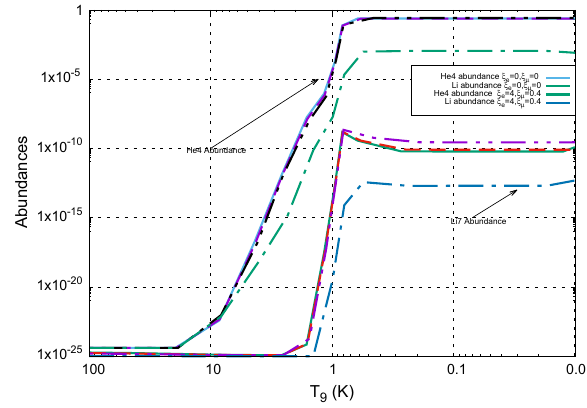
Fig. 7 Plot of the abundances in the presence and absence of inho- mogeneities for electron neutrino degeneracy greater than the muon neutrino degeneracy